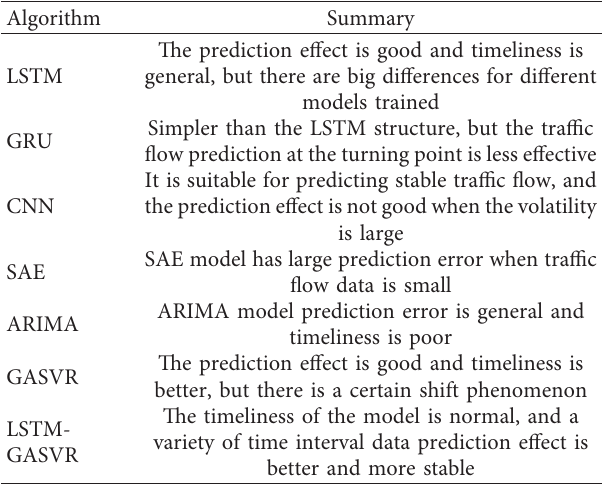
Table 8: Analysis of short-time traffic flow prediction algorithm for different prediction